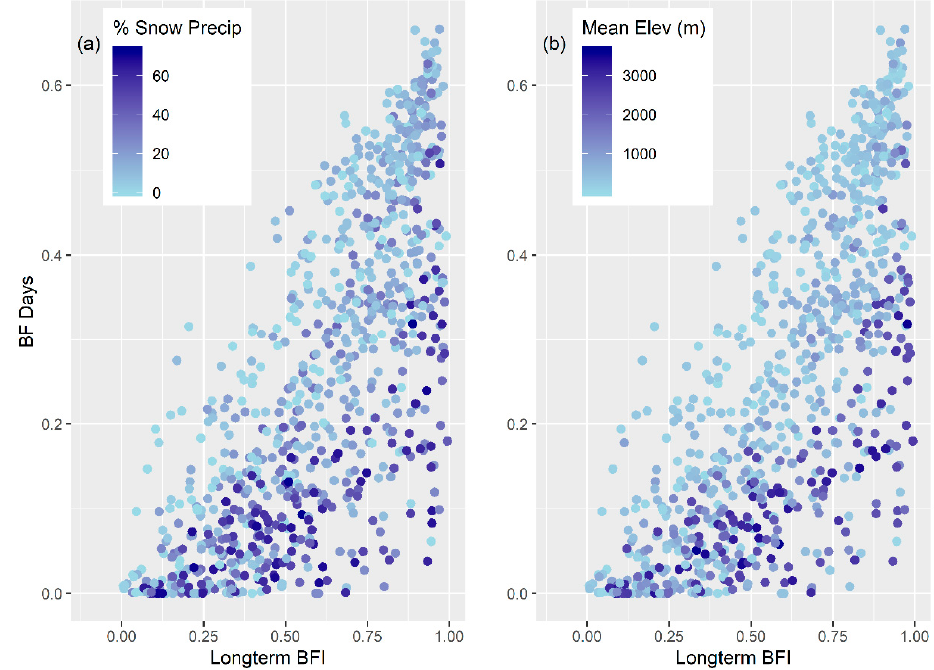
Figure 3. The long-term average base flow index (x-axis) compared to BF Days (y-axis). Sites are colored by the ( a ) average percent of snow that contributes to total annual precipitation and ( b ) the mean elevation within the watershed. Watershed slope is not displayed here, but mimics patterns like mean elevation in the watershed.